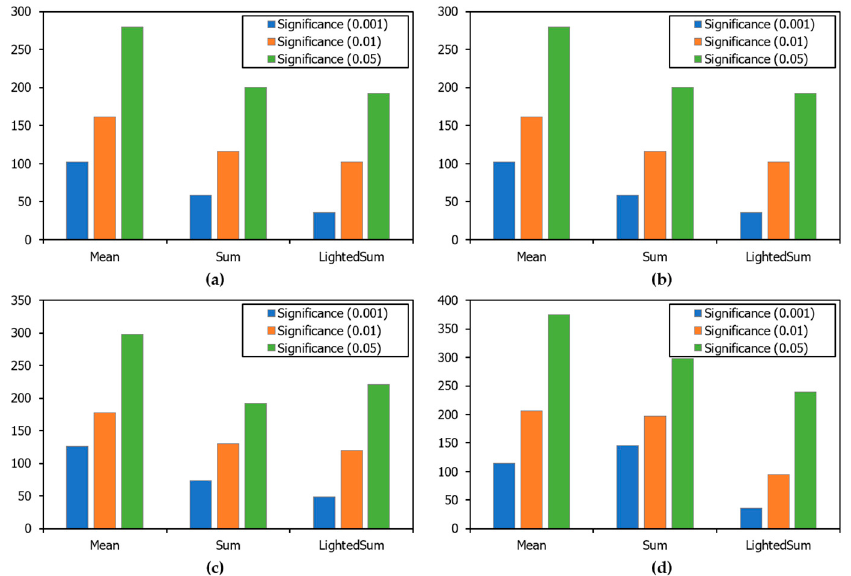
Figure 10. Confidence comparison of association analysis for township hub level and nighttime light indices: ( a ) Shanxi Province; ( b )Henan Province; ( c ) Hubei Province; ( d ) Shaanxi Province.